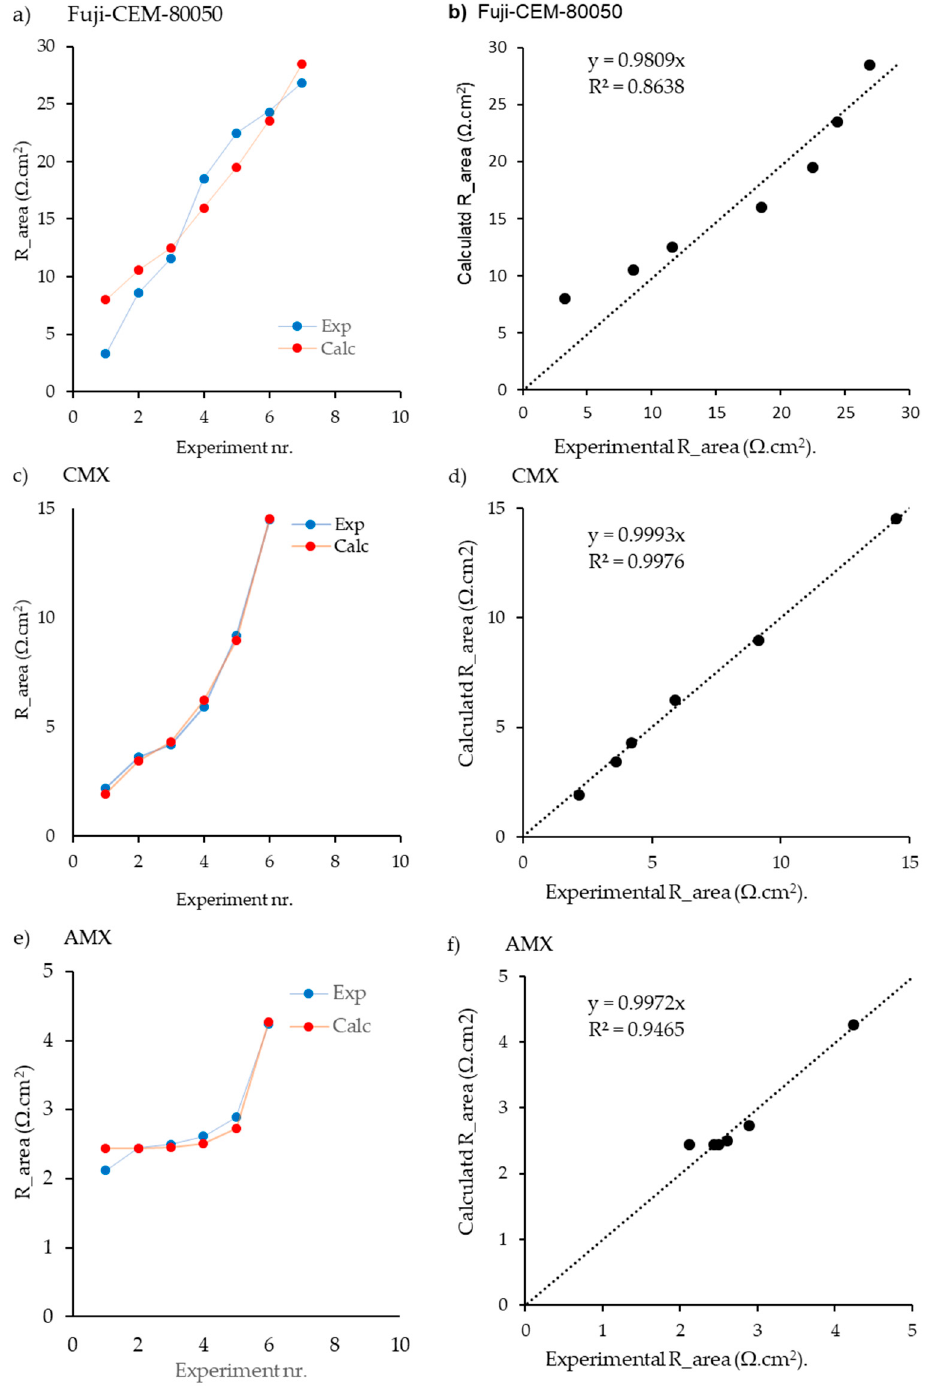
Figure 6. Results of the fitting procedure for Fuji-CEM-80050 (Fujifilm), CMX (Neosepta), and AMX (Neosepta). In ( a , c , e ), lines are added to guide the eye; in ( b , d , f ) the regression lines are shown.